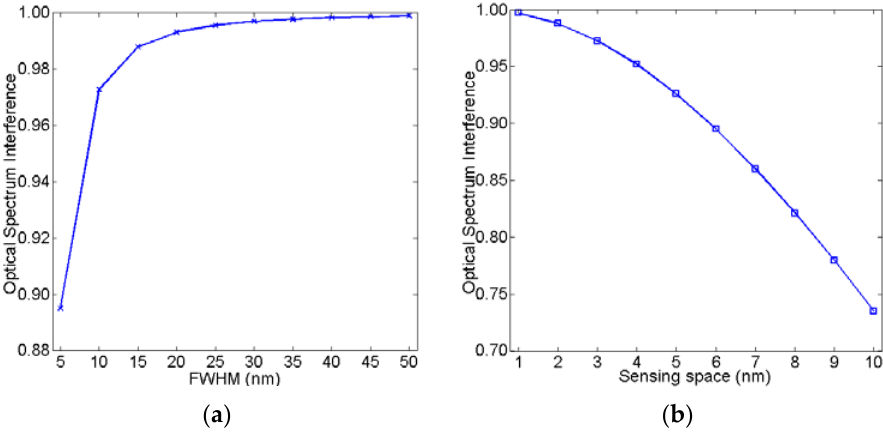
Figure 2. Optical spectrum interference as a function of ( a ) λ FWHM and ( b ) Δ λ , respectively.